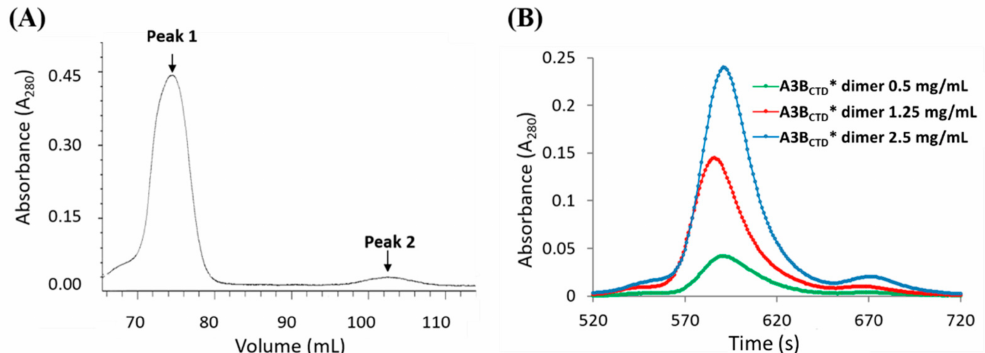
Figure 6. Purification of the A3B CTD * dimer using SEC-FPLC. ( A ) SEC-FPLC elution profile of 5 mg/mL A3B CTD * dimer. ( B ) SEC-FPLC elution profiles of the A3B CTD * dimer at varying concentrations 0.5–2.5 mg/mL. SEC-FPLC was conducted at a flow rate of 0.5 mL/min through the SEC column at 25 ◦